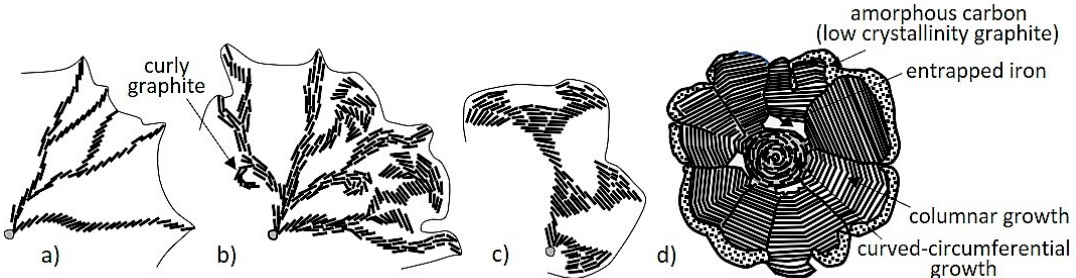
Figure 36. Schematic model illustrating the role of graphite platelets in the construction of various graphite aggregates: ( a ) Tiled-roof lamellar graphite; ( b ) curly, lamellar and compacted graphite; ( c ) chunky and degenerated spheroidal graphite; ( d ) spheroidal graphite; reproduced from [12,42] with permission from Springer.